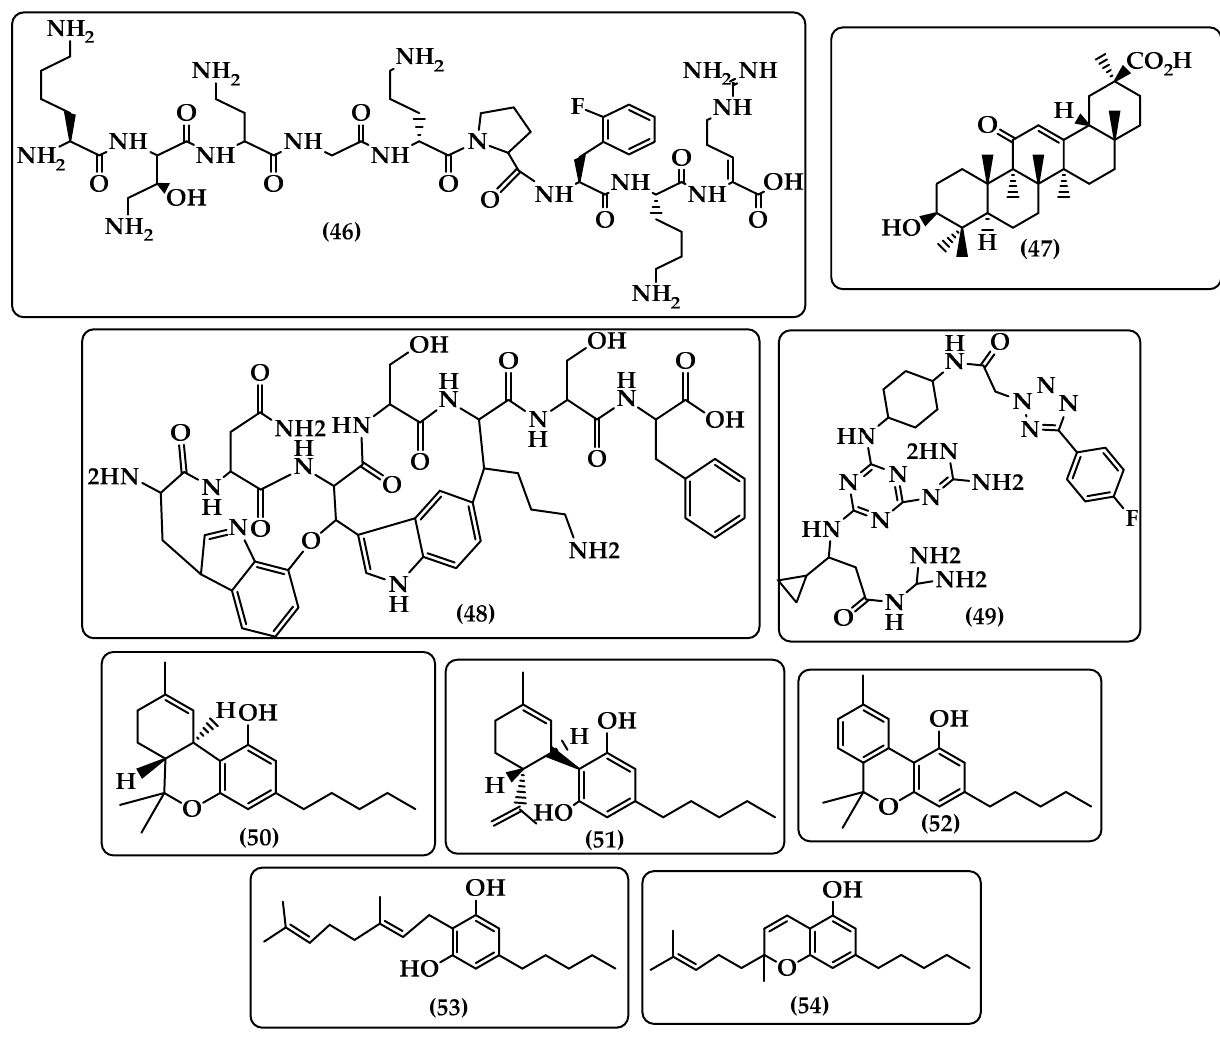
Figure 11. Chemical structure of NOSO-502 ( 46 ), 18 β -glycyrrhetinic acid (GRA) ( 47 ), Darobactin A ( 48 ), MRL-494 ( 49 ), trans- Δ -9-tetrahydrocannabinol (THC) ( 50 ), cannabidiol (CBD) ( 51 ), cannabinol ( 52 ), cannabigerol (CBG) ( 53 ), and cannabichromene ( 54 ).